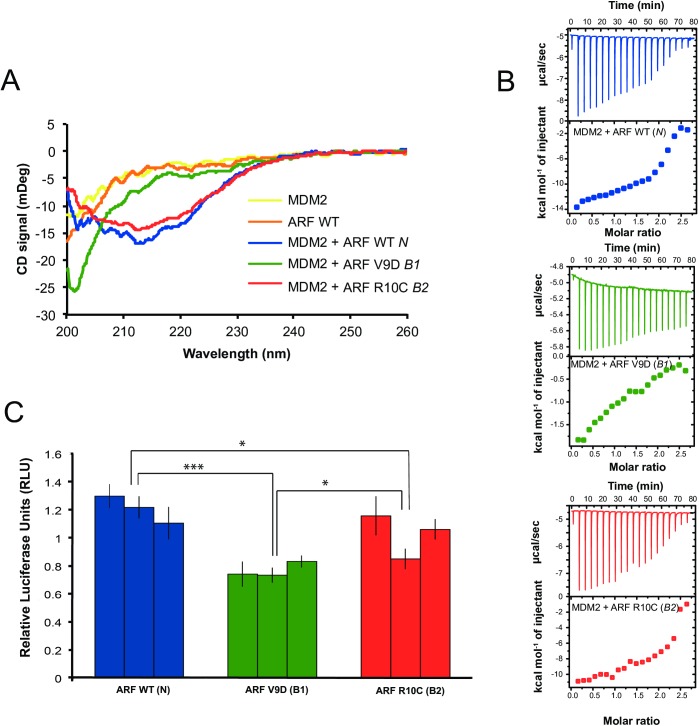
Functional characterization of the V9D and R10C substitutions in chicken ARF.(A) Far-UV circular dichroism (CD) is measured in mDeg and monitors protein secondary structure. Spectra of MDM2204-298, ARF1-14WT, and complexes of ARF1-14WT/MDM2204-298, ARF1-14V9D/MDM2204-298, and ARF1-14R10C/MDM2204-298. MDM2204-298 was used at 10 μM and all peptides at 64 μM final concentrations. Spectra of all peptides in free form and at 25 μM concentration in complex with MDM2204-298 are shown in S5 Fig. (B) Isothermal titration calorimetry (ITC) experiments in which the heat (enthalpy) associated with binding is recorded as μcal/sec for each titration point (top panel) and integrated and normalized against the concentrations of ARF peptide and MDM2204-298 to obtain a binding isotherm (expressed as kcal mol-1 versus molar ratio; bottom panel). In the experiment, ARF peptides (WT, V9D, and R10C, respectively) were titrated into 100 μM MDM2204-298 with the peptide concentration increasing by approximately 10 μM in each titration point. Peaks (top) and integrated energies (bottom) corrected for heats of dilution are shown. Raw data are shown in S6 Fig. (C) Assessment of the effect of the two coding mutations on the interaction between ARF and MDM2 based on a luciferase assay. Reduced luciferase activity implies weaker interaction between ARF and MDM2, monitored as a decreased ability of ARF to protect the transcription factor p53 from degradation (Student’s t-test; *P<0.05, ***P<0.001).